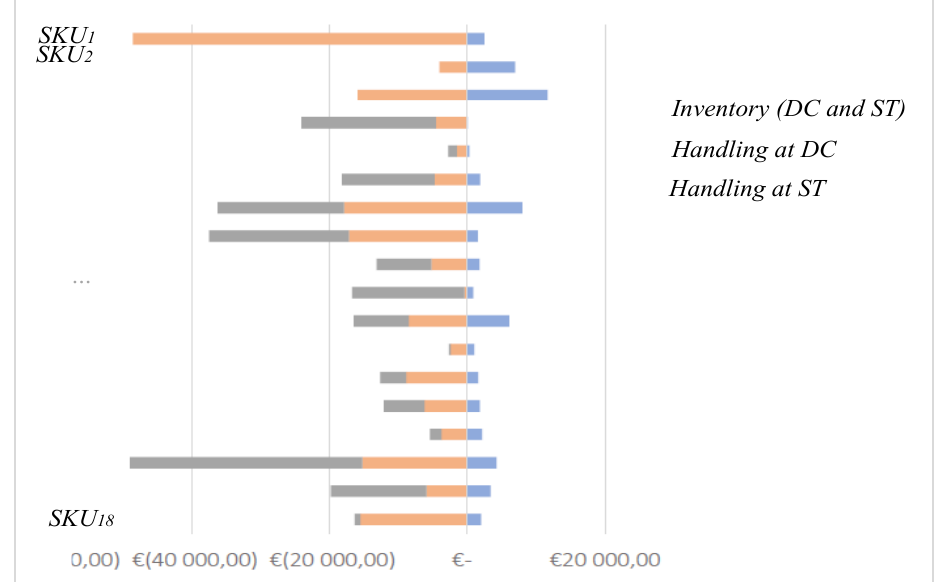
Figure 6. Balance of gains in the pilot field